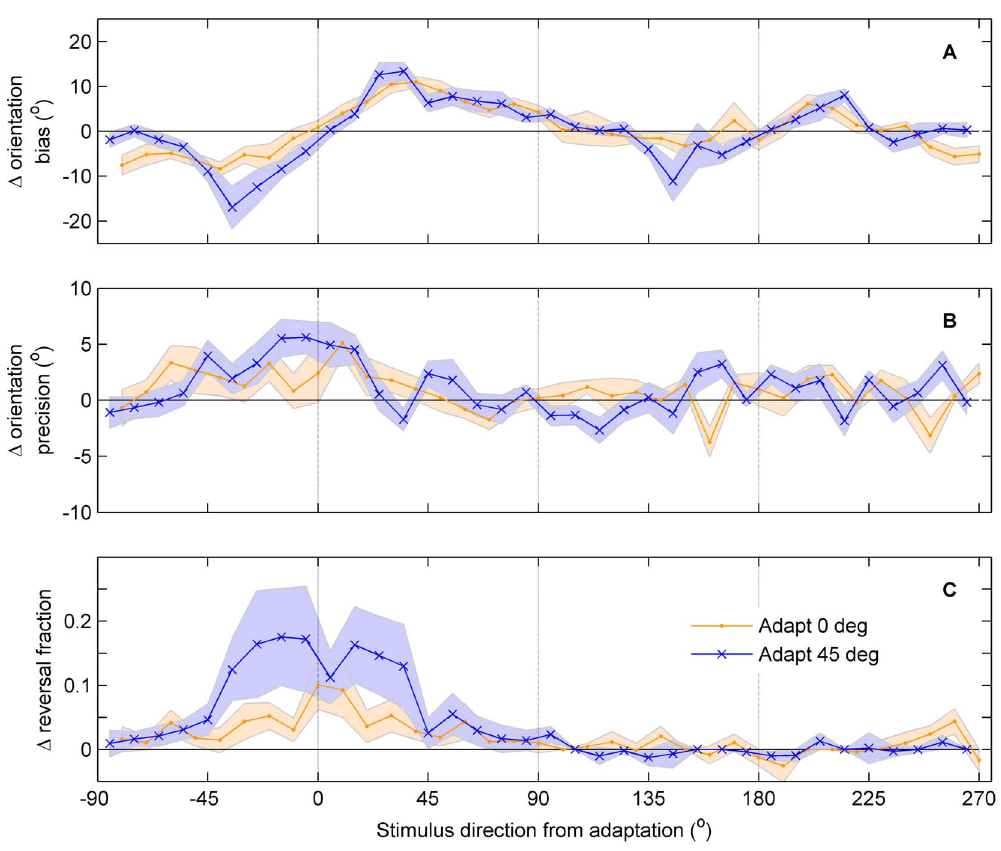
Figure 6. Adaptation. The change in performance of direction judgement following adaptation at 0 u (red) and 45 u (blue X), and their dependence on the stimulus direction relative to adaptation. Mean ( 6 SE ) changes in orientation accuracy (A), precision (B) and reversal fraction (C) are shown for 13 naı¨ve participants. All values are expressed as Adapt – Control .